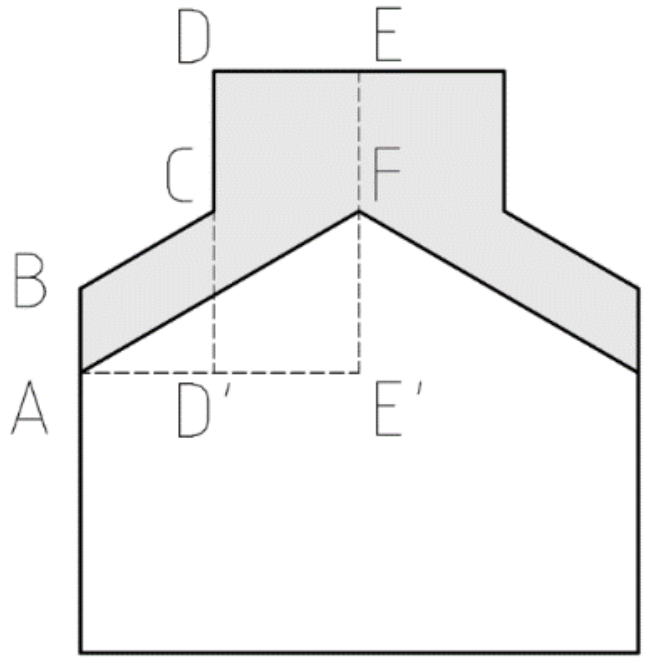
Figure. 9 The gable wall shading parameters of Xiashanhu houses